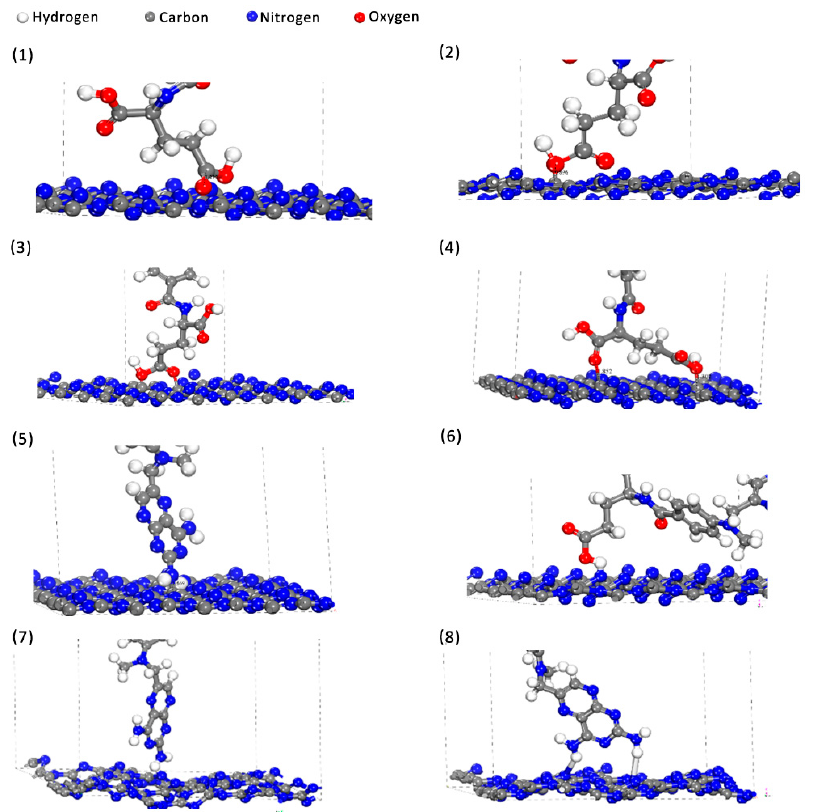
Figure 3. Adsorption positions of the ( 1 ) Carbonyl group on the carbon atom, ( 2 ) Hydroxyl group on the carbon atom, ( 3 ) Carboxylic group on the carbon atom, ( 4 ) Carbonyl group and hydroxyl group on the carbon atom, ( 5 ) Amino group on the carbon atom, ( 6 ) Hydrogen atom of the hydroxyl group on the Nitrogen atom, ( 7 ) Hydrogen atom of the Amino group on the Nitrogen atom, and ( 8 ) two Hydrogen atoms of the Amino group on the carbon atom.